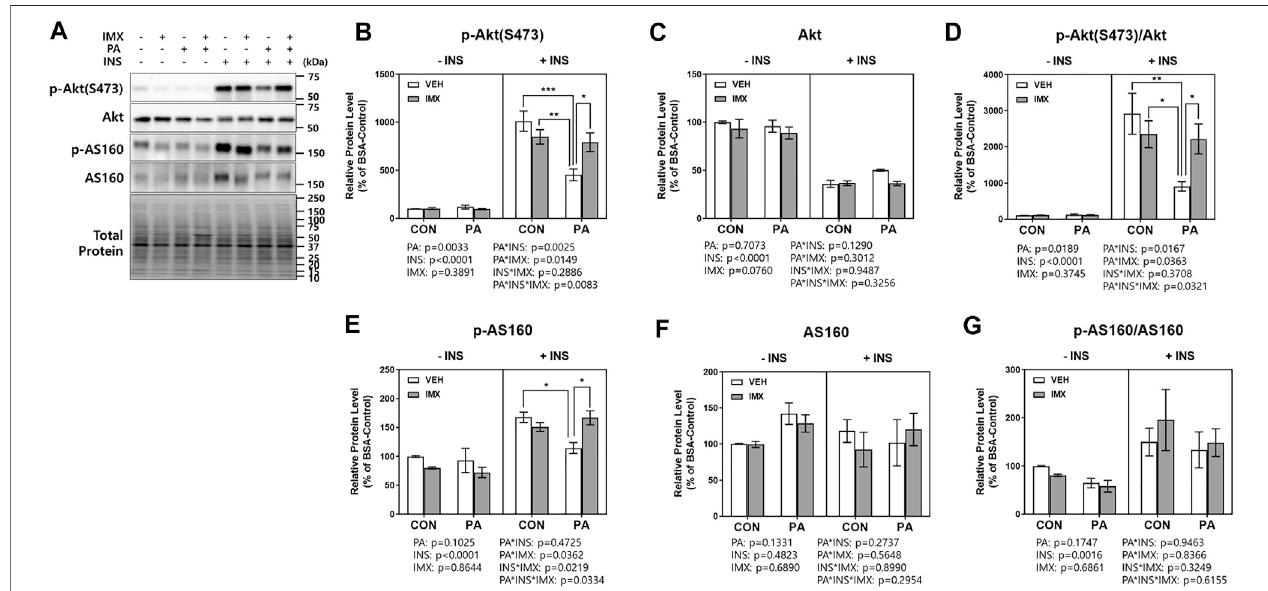
FIGURE 6 | Effectof imoxin on insulin-stimulated Akt and AS160 phosphorylation in presence or absence of palmitate in C2C12 myotubes. The cells were treated with imoxin (IMX) at 5 μ M with/without 0.5 mM palmitate (PA) for 24 h. Protein level of each biomarker was measured by western blot. (A) Representative band images and (B – G) quanti fi cation data of each biomarker are shown. Differences between treatments were analyzed by three-way ANOVA (IMX x PA x insulin). Values are presented as mean ± SEM (N = 3). * p < 0.05, ** p < 0.01 and *** p < 0.001 by Tukey ’ s post hoc analysis after three-way